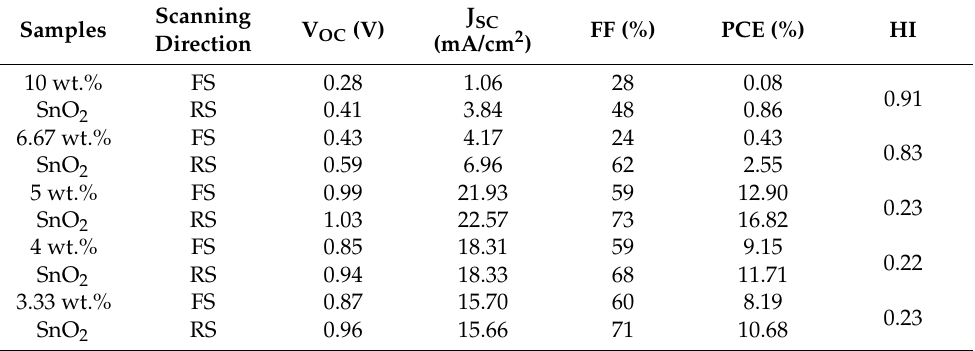
Table 2. Data of performance of PSCs prepared with SnO 2 colloid solution of different concentrations.